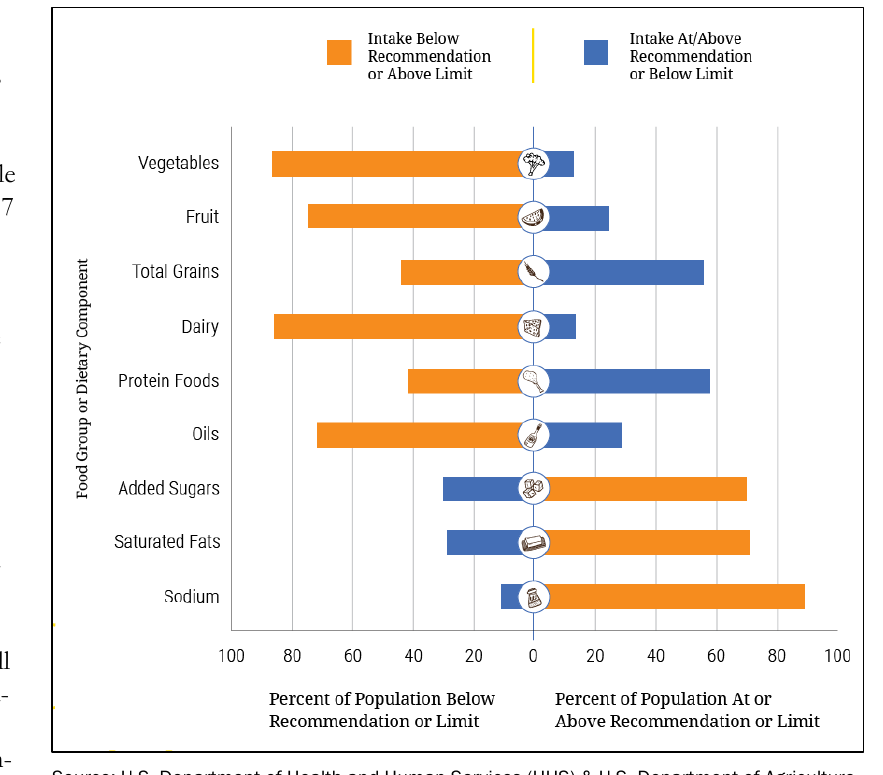
Figure 2. Dietary Intakes Compared to 2015-2020 U.S. Dietary Guideline